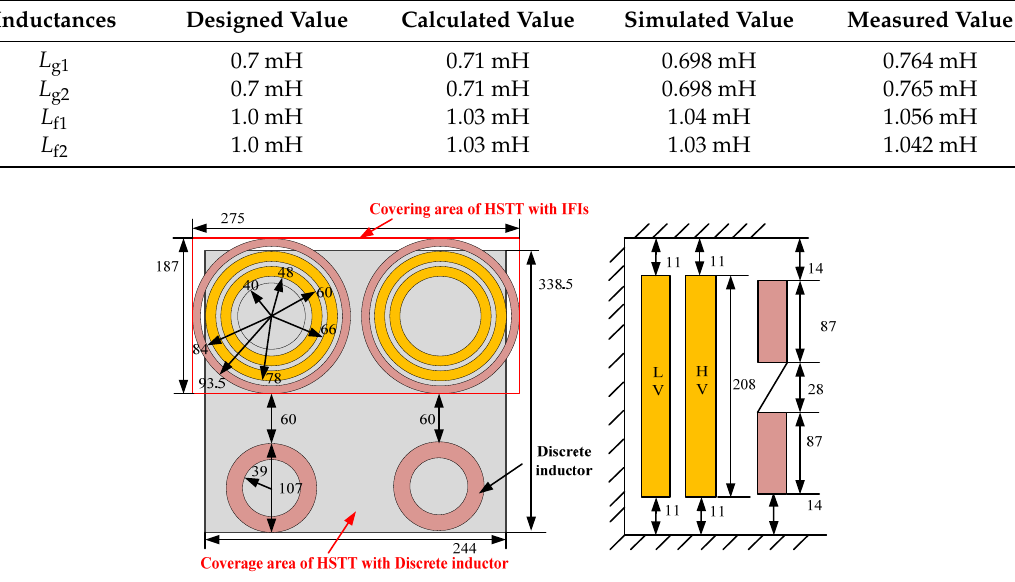
Figure 16. Experimental results of the HSTT with an IFI-based LCL-type filtered single-phase converter. Figure 17. Experimental results of the HSTT with a discrete inductor-based LCL-type filtered single- phase converter. 5. Conclusions In this paper, a scheme for a single-phase LCL-type converter is adopted in the traction drive system for high-frequency harmonics suppression. Considering that the space in high-speed trains is extremely limited, an innovative HSTT with IFIs is proposed. The IFI has an effective magnetic decoupling structure, and the installation space of the filter device can be greatly reduced. Simulation and experimental results show that the proposed IFI-based LCL-type filter scheme can achieve similar harmonic attenuation performance as the discrete LCL-type filter scheme. The IFI method can also be applied to other engineering practices.